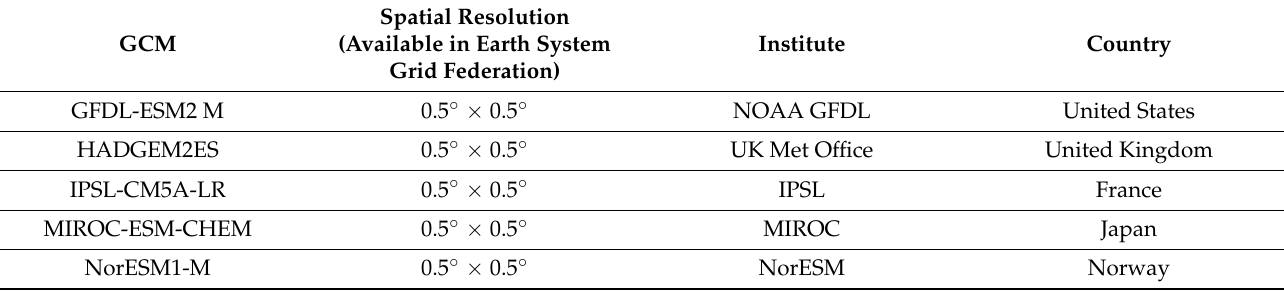
Table 2. GCMs and other information used in this